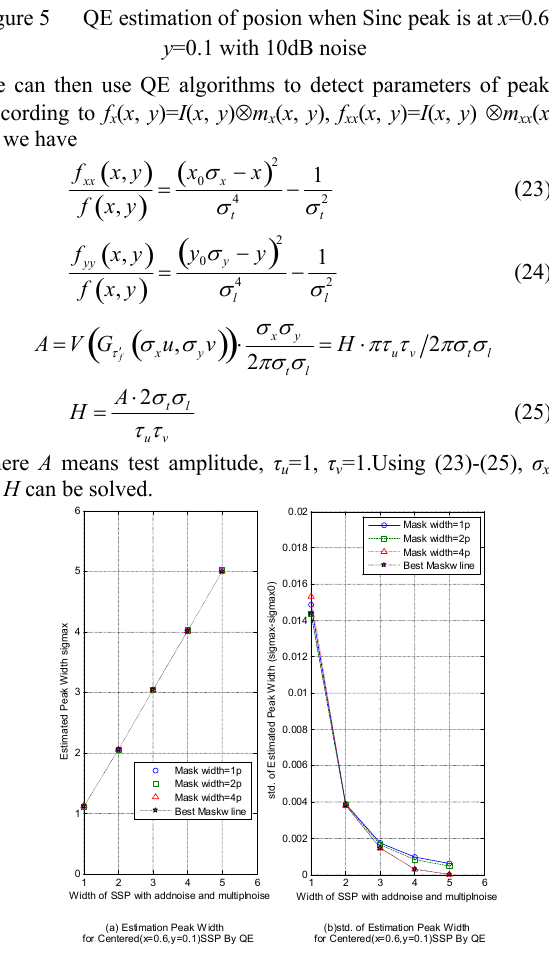
MaskAzimuth (a)3D Synthesized Sinc Peak without Gauss